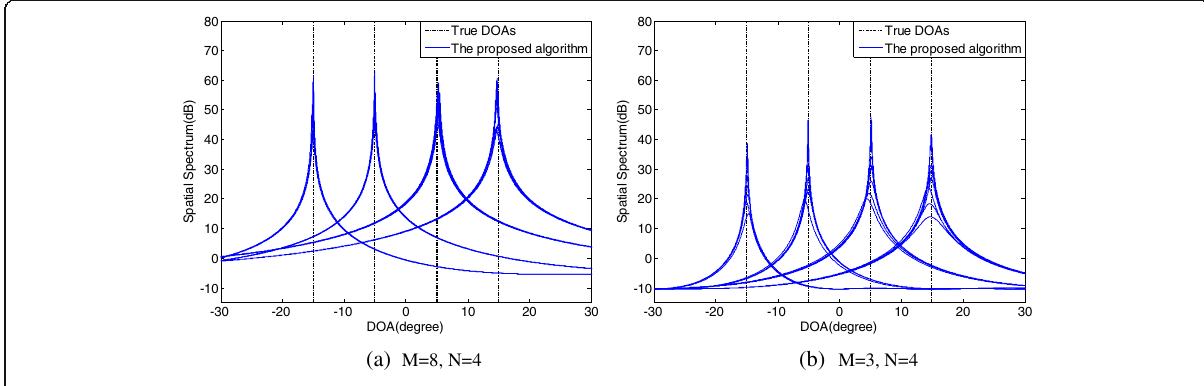
Fig. 6 The DOA estimation in the underdetermined cases, ( a ) M = 8, N = 4, ( b ) M = 3, and N = 4